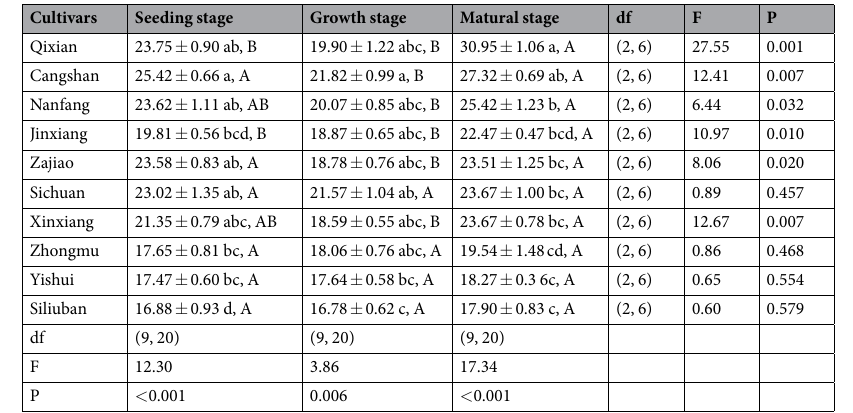
Table 3. Thiosulfinates contents in different vavieties garlic in different growth stages. Each value represents the average ( ± s.e.) of three replicates. The different small letters at the first column after each datum indicate significant differences in thiosulfinates contents among cultivars ( P < 0.05) in the same growth stage, and the different capital letters at the second column after each datum indicate significant differences in thiosulfinates contents among growth stages ( P < 0.05) in the same garlic cultivar. Data was analyzed with ANOVA (Tukey’s